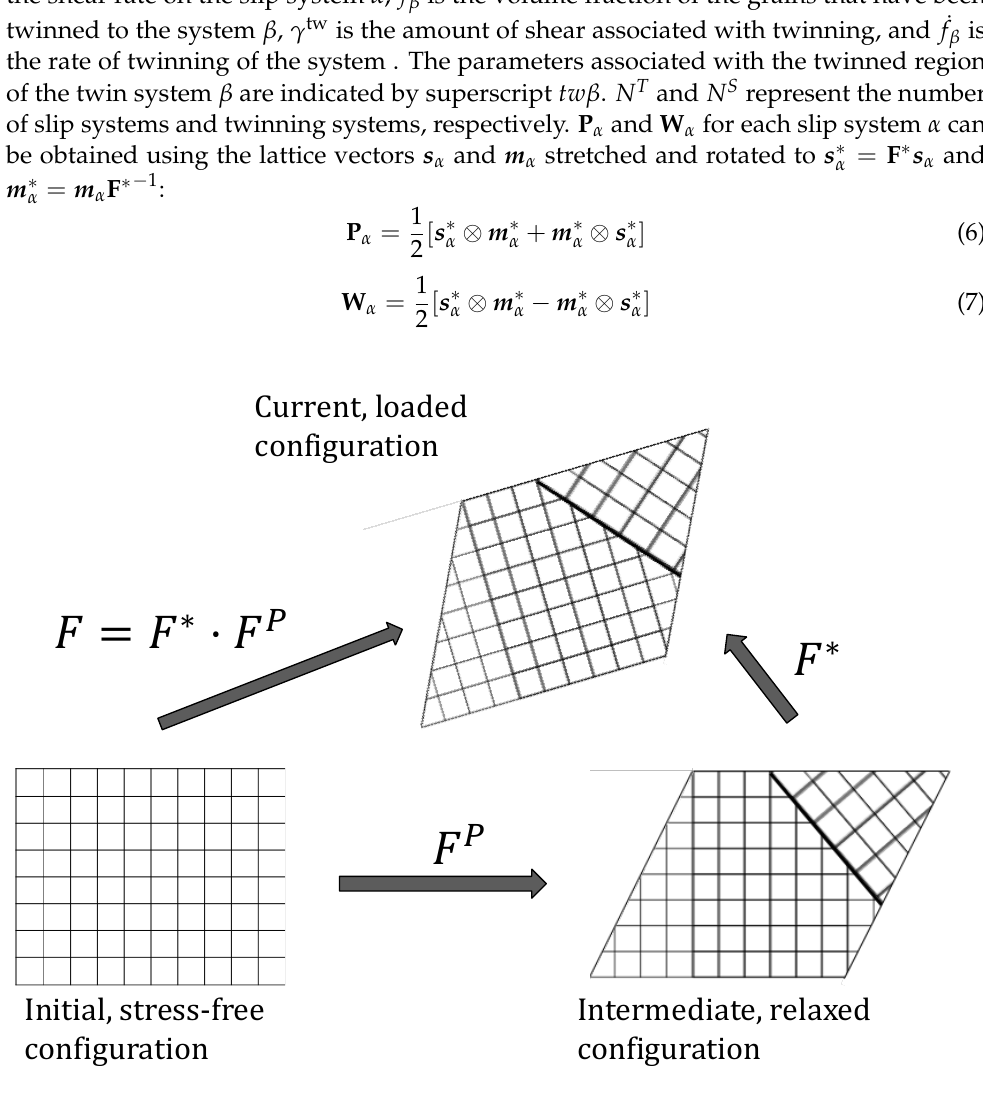
Figure 5. A schematic of the decomposition of the deformation gradient with the twinned region included in the plastic term, data from